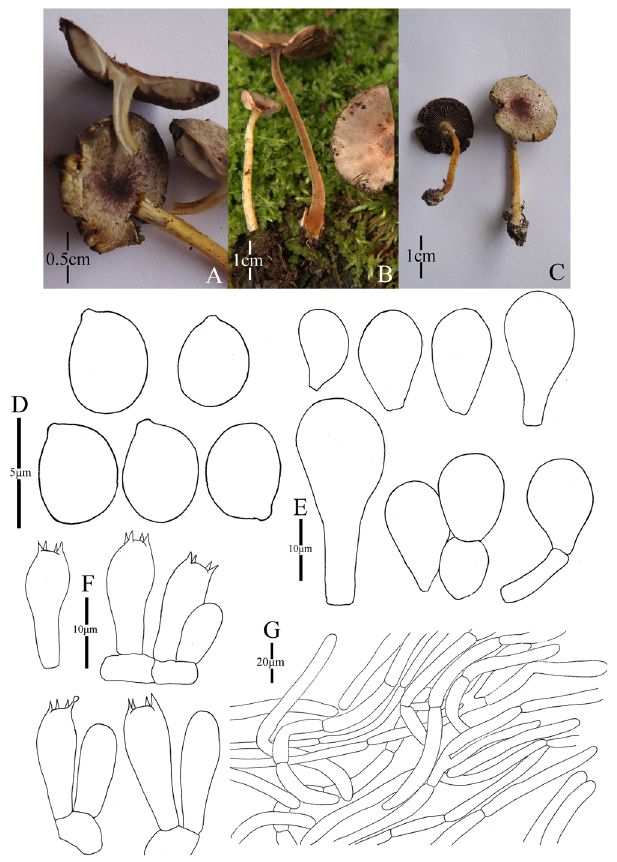
Figure 4. Morphology of Agaricus blatteus ( ZRL2012004 , holotype), ( A – C ): Basidiome in field ( A , C : ZRL2012004 ( B ): ZRL2014282 ); ( D ): Basidiospores, ( E ): Cheilocystidia, ( F ): Basidia, and ( G ): Pileipellis